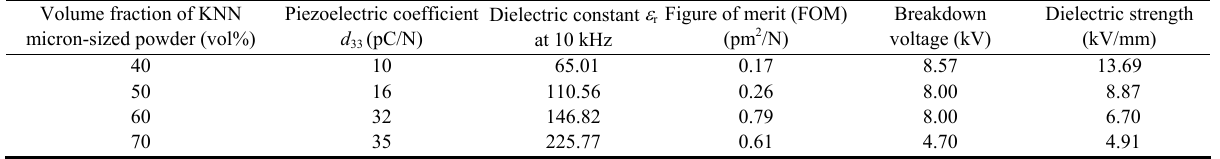
Table 1 Physical properties of PVDF–KNN microcrystal